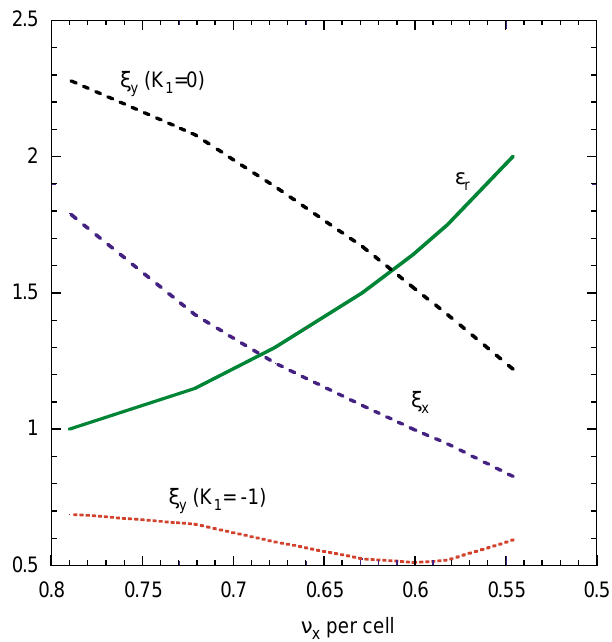
FIG. 10. (Color) TME cell detuning ´ r and the horizontal and vertical chromaticities versus the horizontal phase advance per cell in the 6 m NLC MDR cell; vertical phase advance is matched to be 1 (cid:1) 3 of the horizontal. The vertical chromatic- ity is plotted for a cell with a defocusing gradient of 66 kG (cid:1) m in the bending magnet and a cell without any gradient in the bending